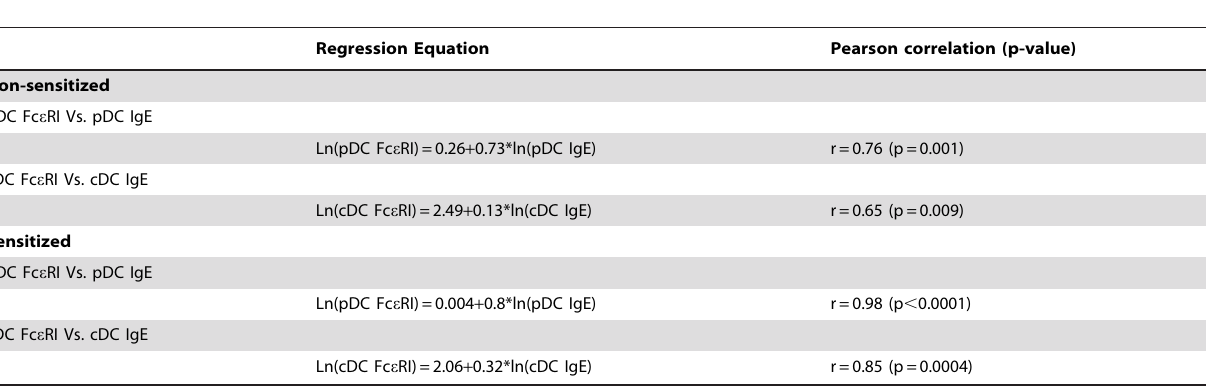
Regression Equation Pearson correlation